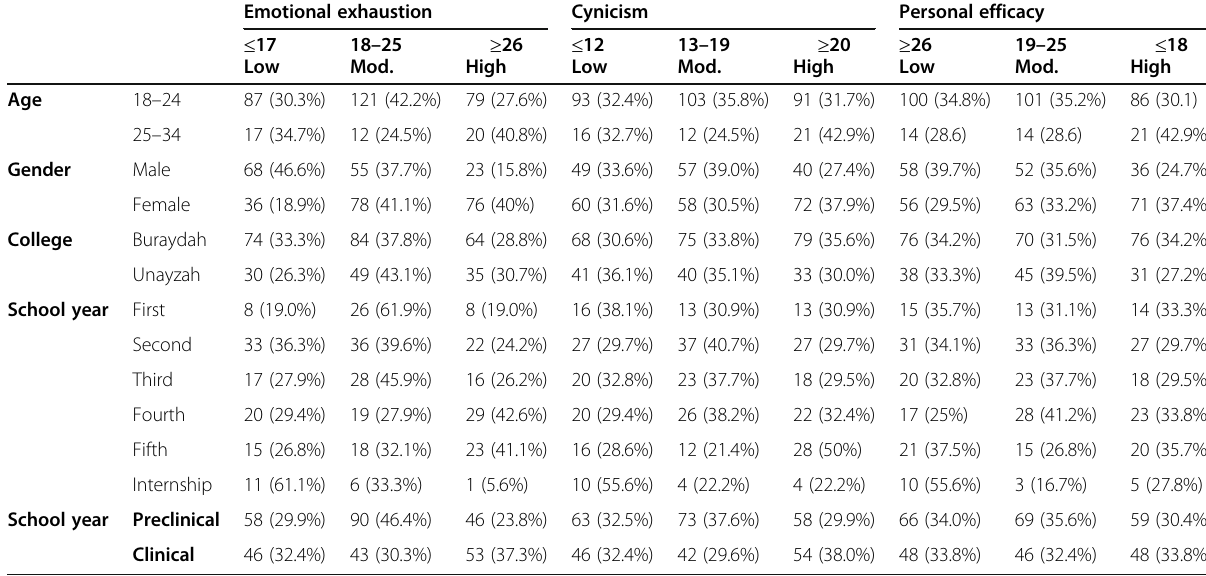
Table 2 Comparison of MBI-SS subscales with students ’ demographic Emotional exhaustion Cynicism